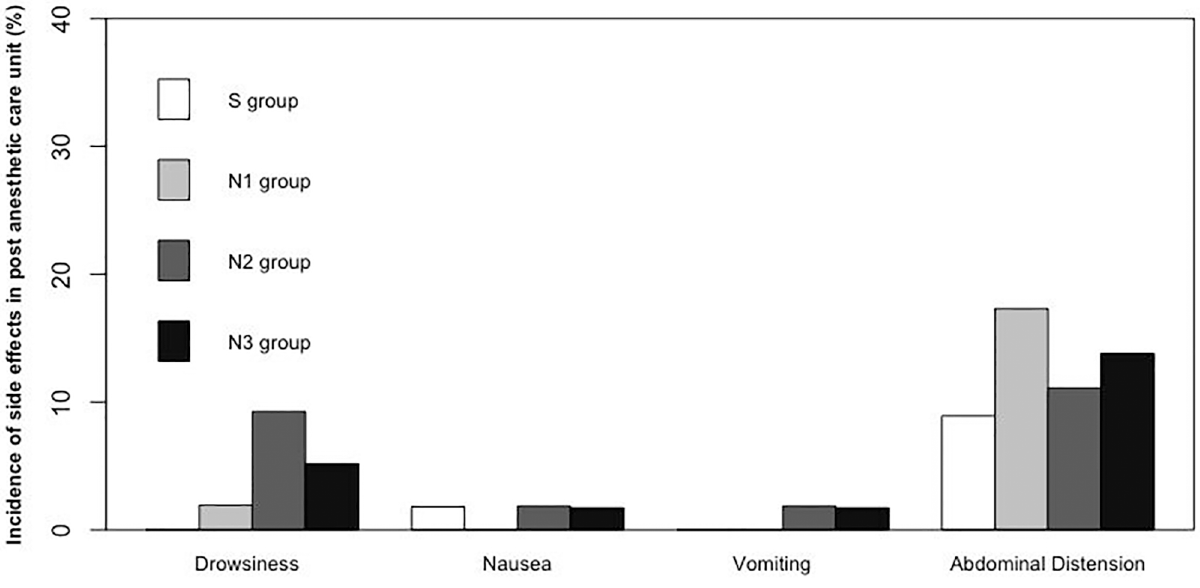
Fig 3. Side effectsobserved in the post anesthesia care